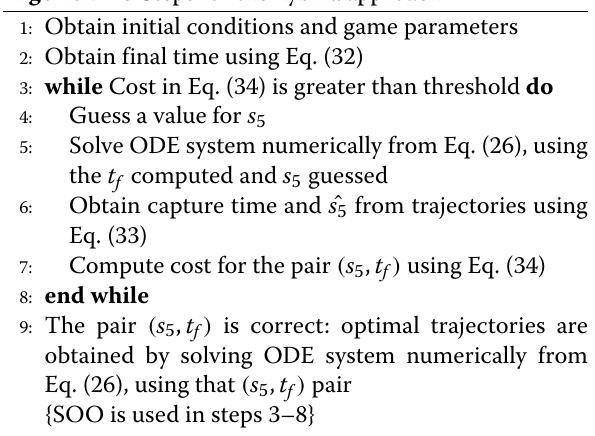
Algorithm 3 Steps for the hybrid